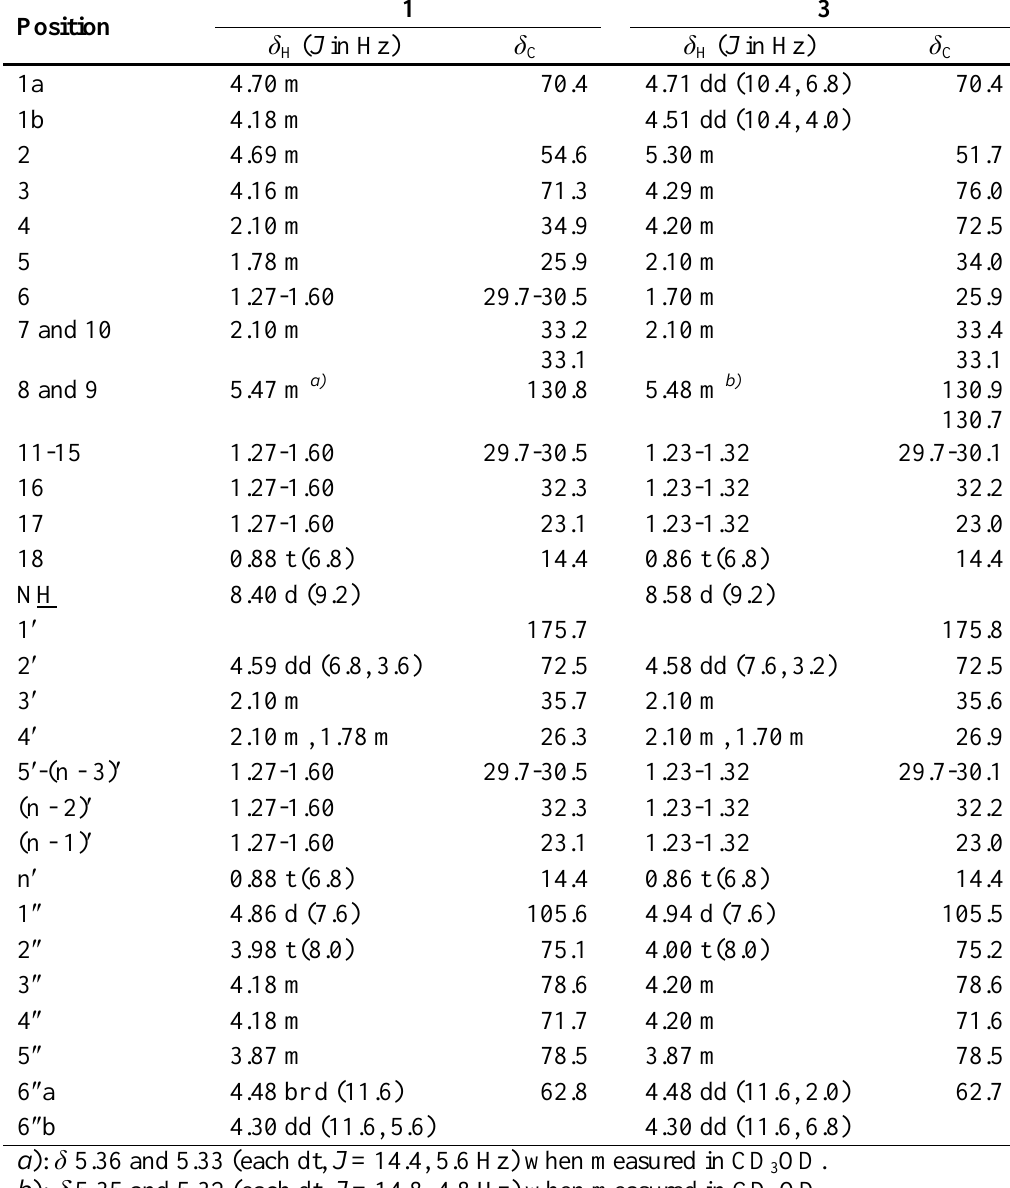
Table 1. 1 H- and 13 C-NMR Data of 1 and 3 (in pyridine- d